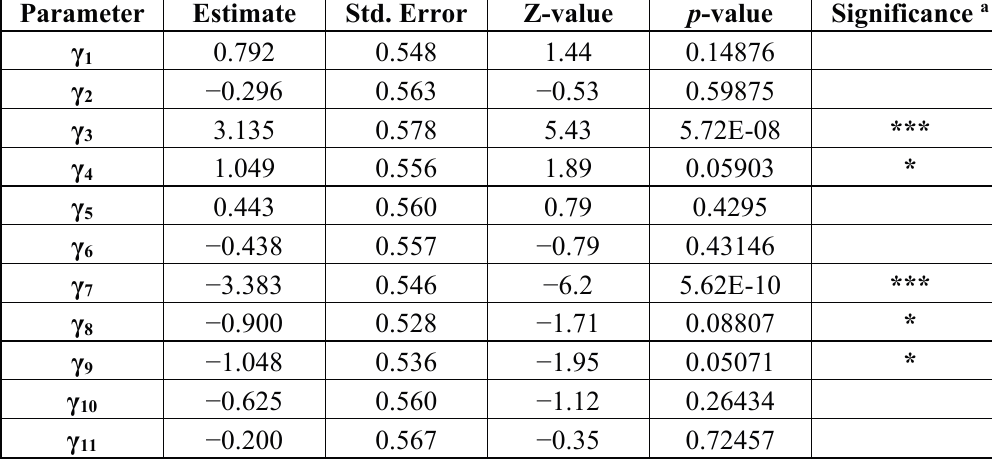
Table 5. Parameters for variation of QOL between